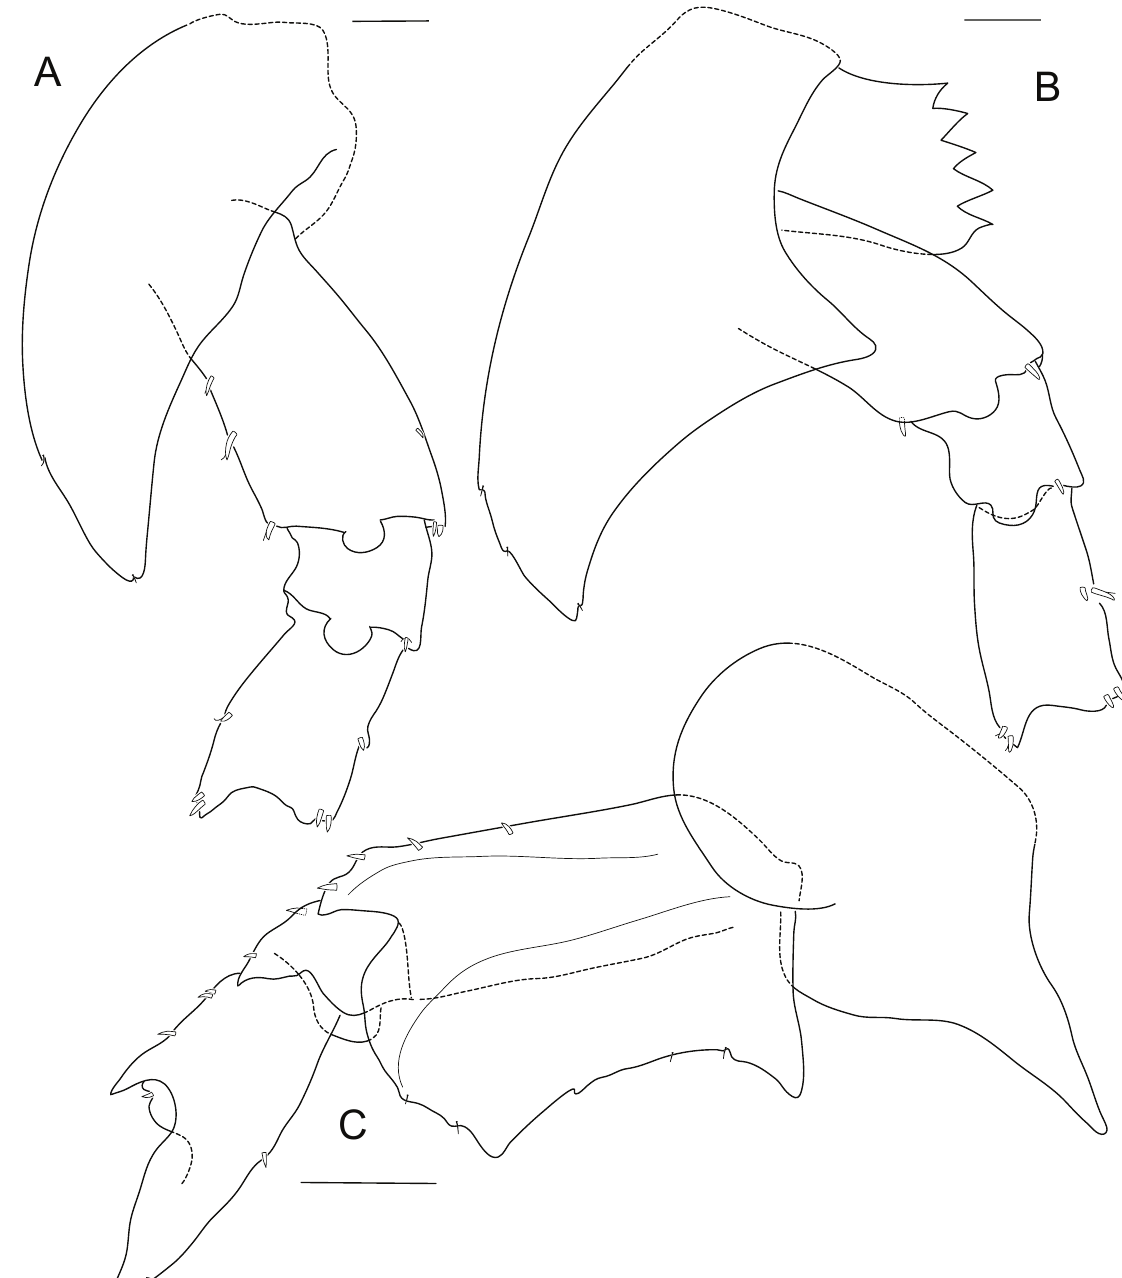
Fig. 5. Labriphimedia meikae nov. sp., holotype ♂, 6 mm, NIWA 84598. A . Pereopod 3. B . Pereopod 4. C . Pereopod 5. Scale bars: a-B = 100 µm. C = 200